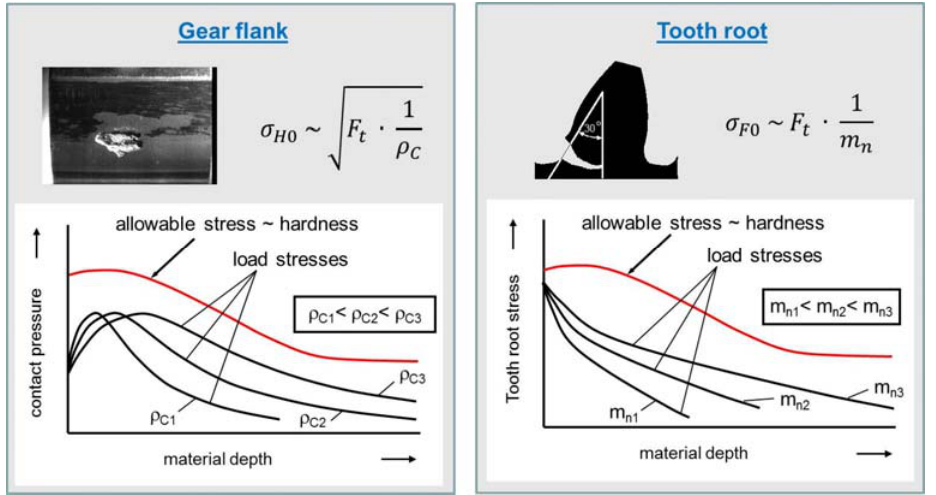
Figure 5. Comparison of gear flank contact pressure (left) and tooth root stress (right) vs. the allowable stress over material depth depending on the gear size represented by the curvature ρ C and module m n for a given tangential driving force F t [7].